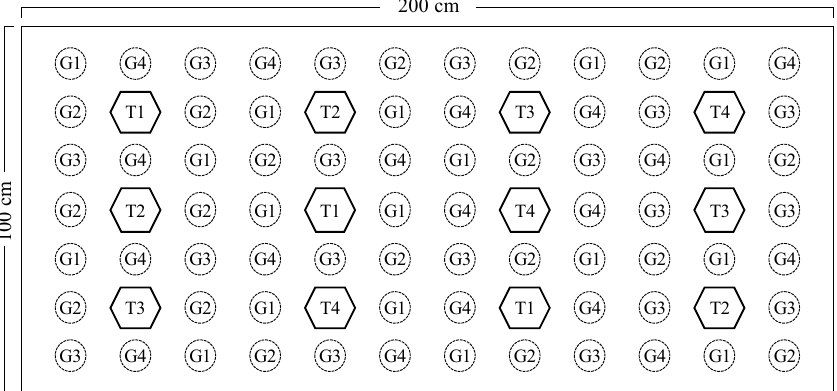
Figure 1. Grass and tree planting design for each box experiment (G1 = purun grass, G2 = typha grass, G3 = batibati grass, G4 = vertiver grass, T1 = galam tree, T2 = longkida tree, T3 = bangkal tree, T4 = kayuputih